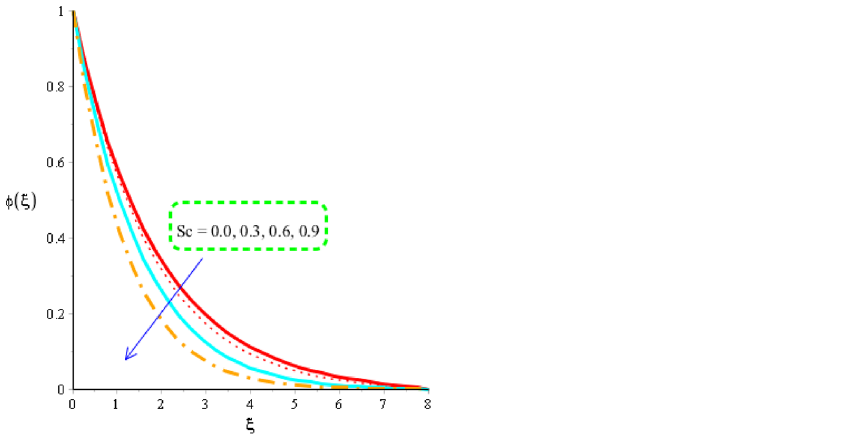
Figure 10. Distribution in φ(η) versus Sc .